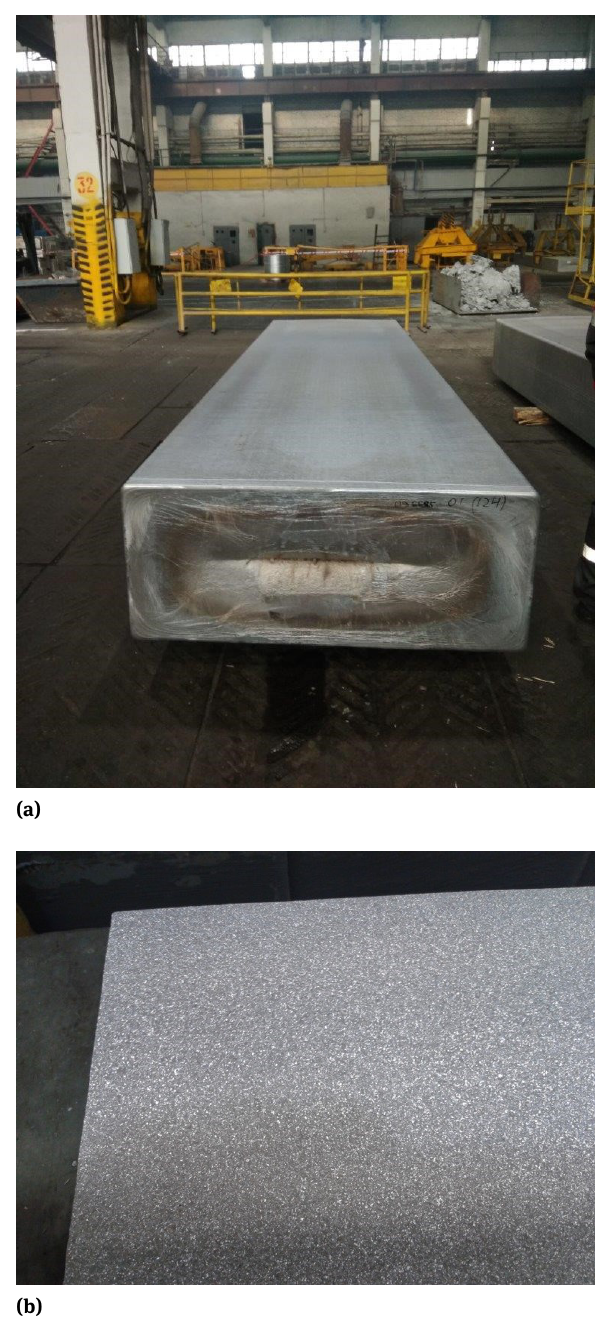
Figure 2: The type of ingot (a) obtained under the industrial condi- tions of the Bratsk aluminium smelter, and its macrostructure (b)